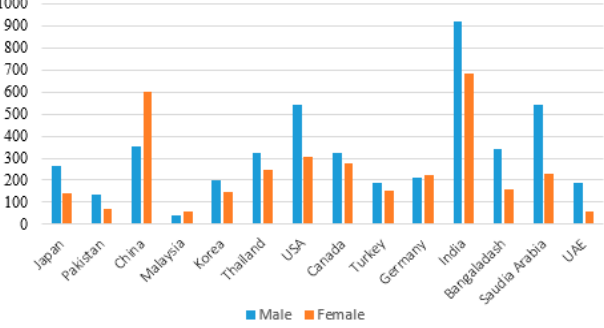
Figure 8. Gender distribution of participants in the SNS-based RE process.